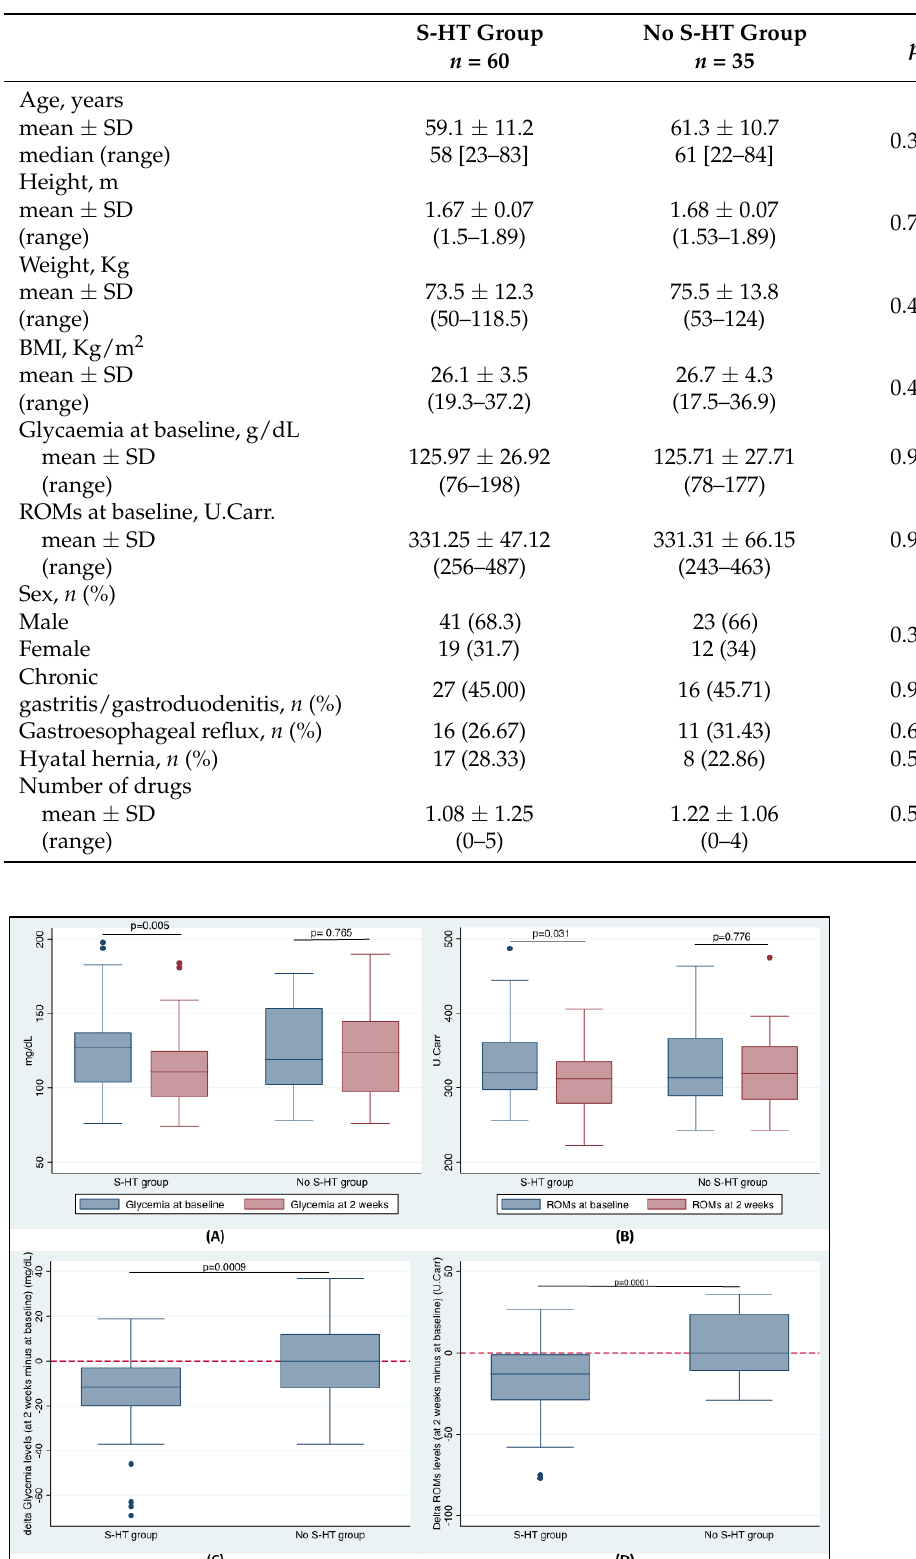
Table 2. General characteristics of the subpopulation considered for the analysis.